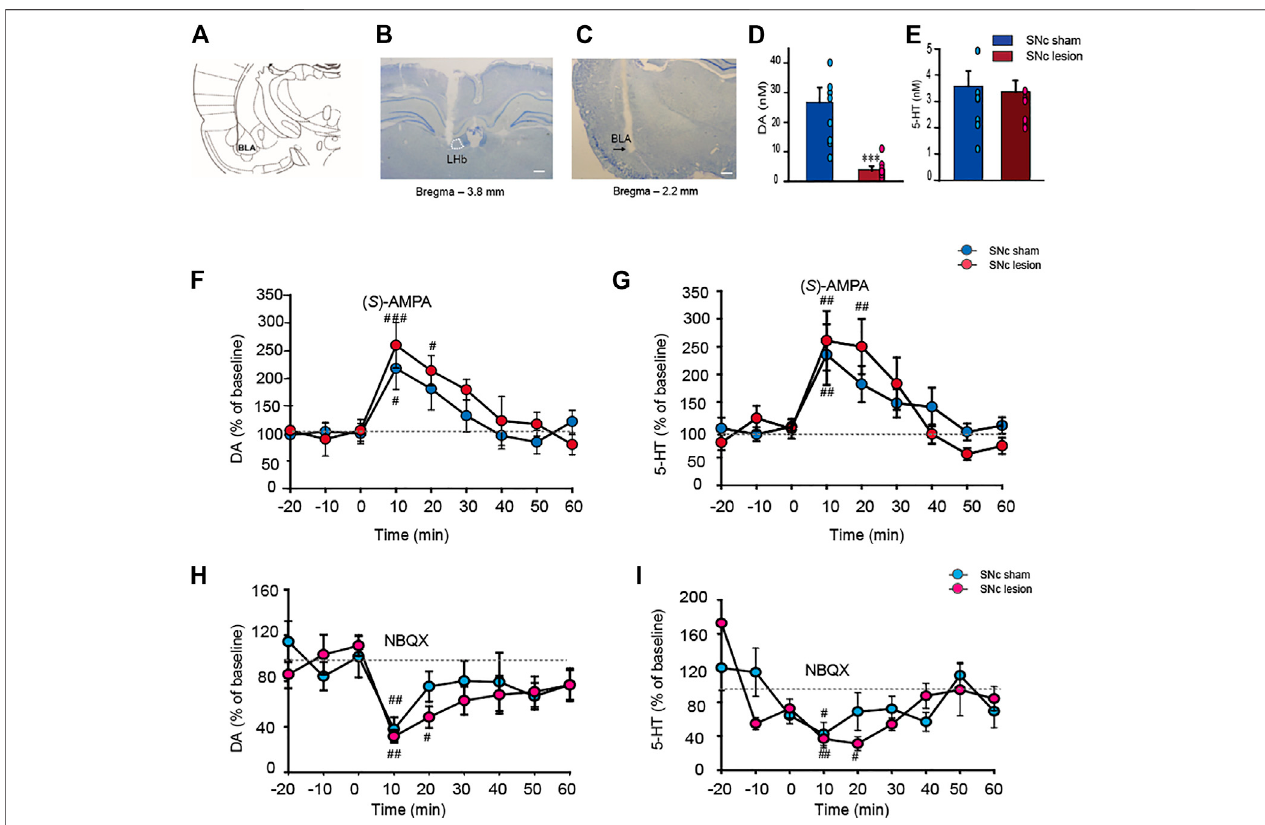
FIGURE 5 | The alterations of the extracellular DA and 5-HT levels in the BLA in sham-operated and SNc-lesion rats prior to and following an intra-LHb injection of the AMPARs agonist ( S )-AMPA or antagonist NBQX. Schematic drawing adapted from Paxinos et al. (1980). (A) . The microinjector tip aimed at the LHb (B) and photomicrographsofcresylvioletstainingindicatedthesitesofmicrodialysisprobesintheBLA (C) .UnilateralSNclesionsinratssuppressedtheDAlevelintheipsilateral BLA relative to sham-operated rats (D) but did not impact the5-HT level [ (E) ; n =9 rats/group].Intra-LHb injection of ( S )-AMPA (0.0375 μ g/0.3 μ l) raised the levels ofDAand5-HTintheBLAinbothshamandSNc-lesionrats[ (F,G) ; n =8rats/group],whileNBQX(0.5 μ g/0.3 μ l)inhibitedtheconcentrationsofDAand5-HTintheBLA [ (H,I) ; n =7rats/group).Although( S )-AMPAandNBQXaffectedtheDAand5-HTlevelsinbothgroups,thedurationsoftheincreaseordecreasewerelongerinthelesion group than in sham-operated rats. ** p < 0.001 vs . sham-operated rats; # p < 0.05, ## p < 0.01, ### p < 0.001 vs . baseline, two-way ANOVA with repeated measures followed by Bonferroni ’ s test. Data are represented as means ± SEM.